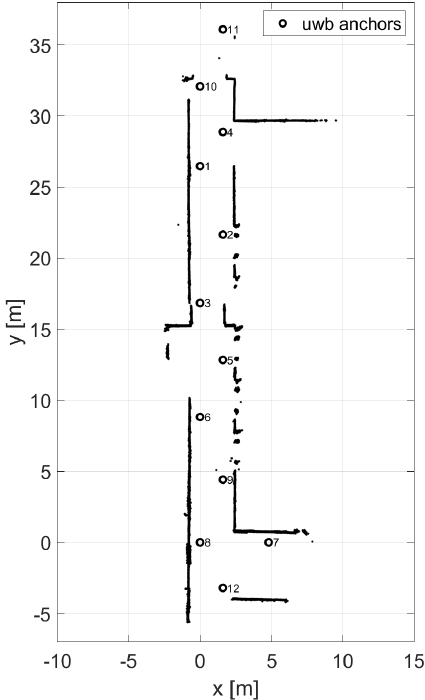
Figure 3. UWB anchor distribution.